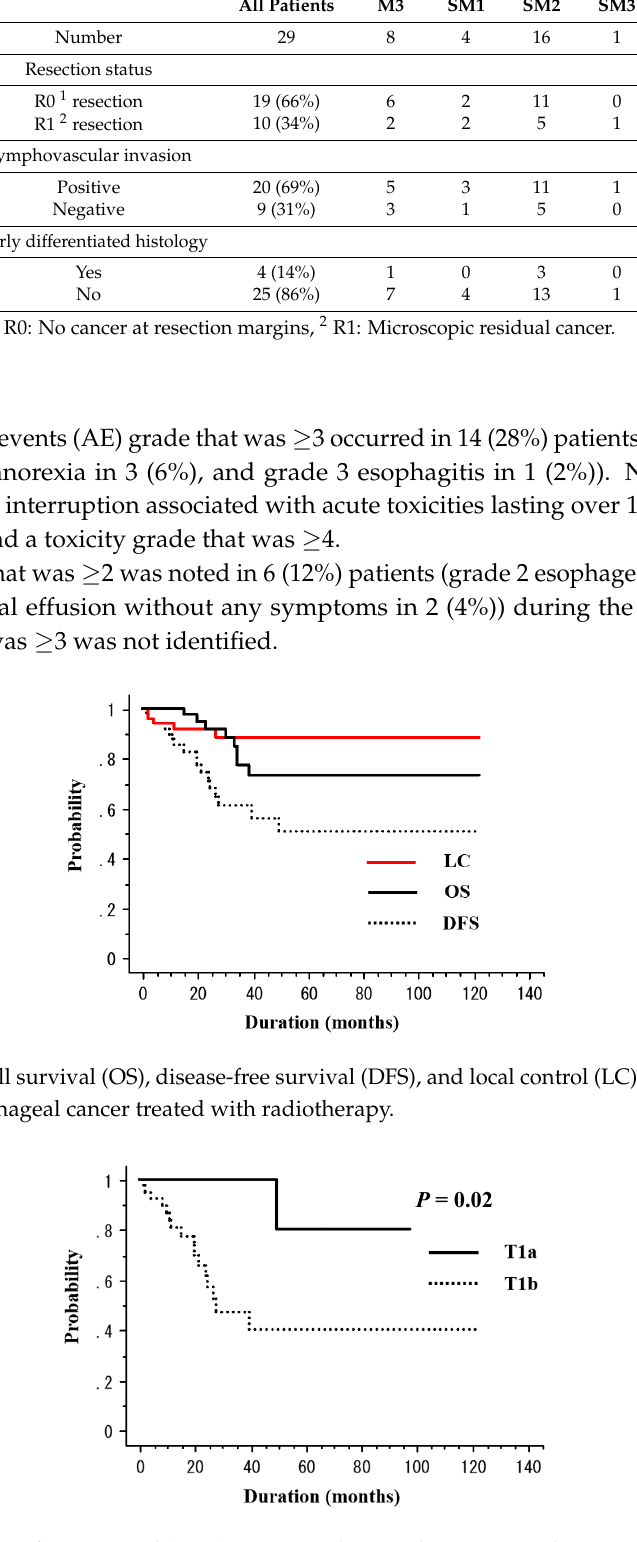
( a ) ( b ) Figure 3. The local control (LC) rate according to the tumor length and the endoscopic submucosal dissection (ESD) treatment. ( a ) The LC rates are 100% in patients with tumors <3 cm and 79.3% in those with tumors ≥ 3 cm at 3 years ( p = 0.046). ( b ) The LC rates are 93.3% in patients who received ESD treatment and 80.4% in those who did not receive ESD treatment ( p = 0.067).